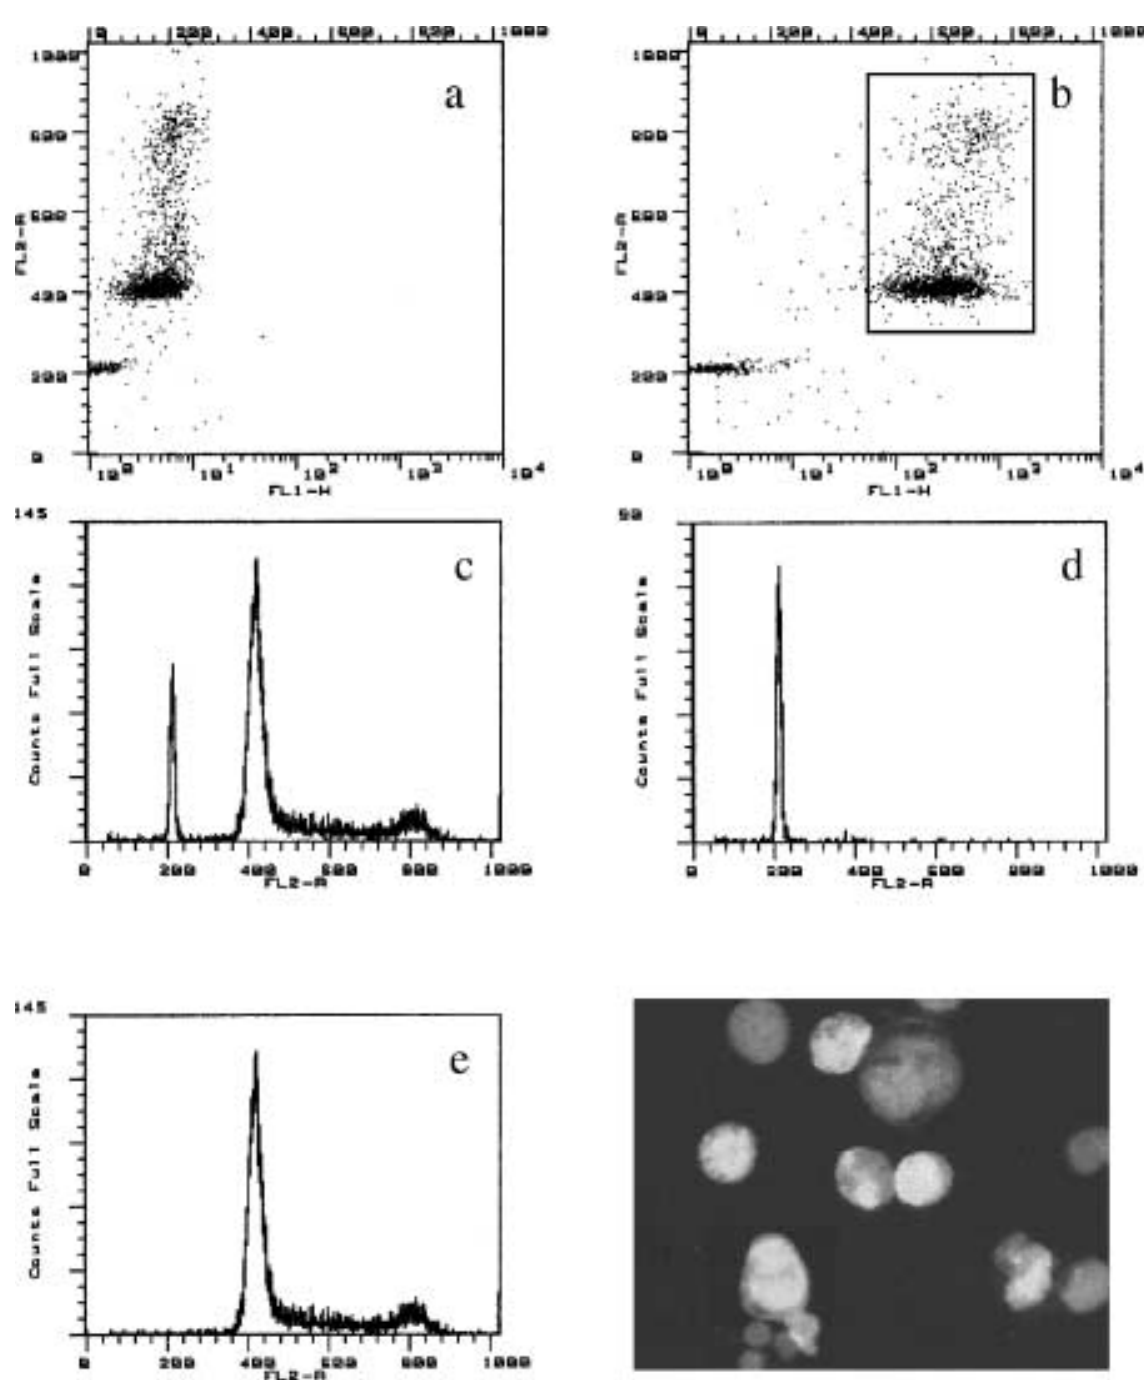
Fig. 1. HeLa cells and lymphocytes: Cytokeratin/DNA labeling. The dot-plots of the cytokeratin labeling (FL1-H, FITC, green, log, relative fluorescence values (RFV)) and DNA labeling (FL2-A, PI, red, linear, RFV) are demonstrated as negative control (a) and cytokeratin labeling (b). The histograms for the red fluorescence of DNA labeling are shown for all cells (c), FL2-A, PI, lin, RFV), for cytokeratin negative cells (d), FL2-A, PI, lin RFV) and for cytokeratin positive cells (e), FL2-A, PI, lin, RFV). Due to cytokeratin labeling cytokeratin separate analysis of cytokeratin positive cells (HeLa) can be differentiated from smaller lymphocytes